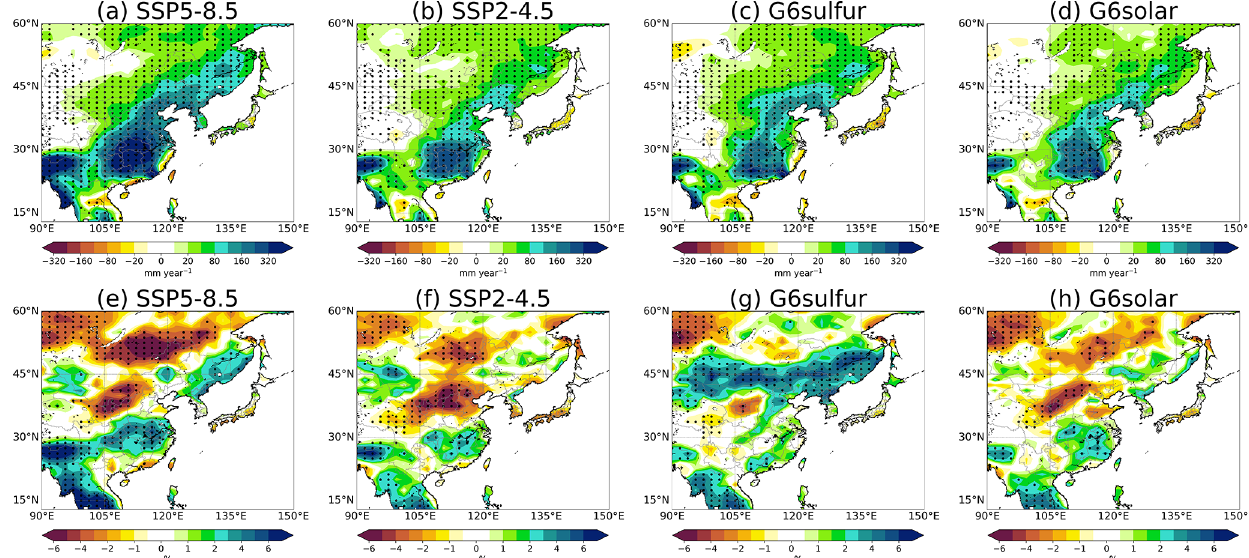
Figure 9. Absolute changes in the annual accumulation of AR-related precipitation (a–d) and the fractional contribution of ARs to annual total precipitation amount (e–h) for the future period (2071–2100) relative to the historical baseline (1981–2010). Stippling indicates changes that are statistically significant at a confidence level of > 95% ( p value < 0.05 based on Student’s t